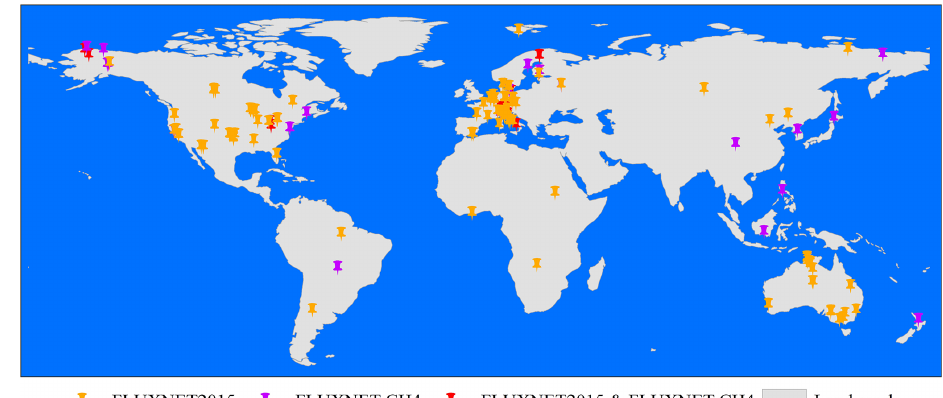
Figure 1. Location of eddy covariance